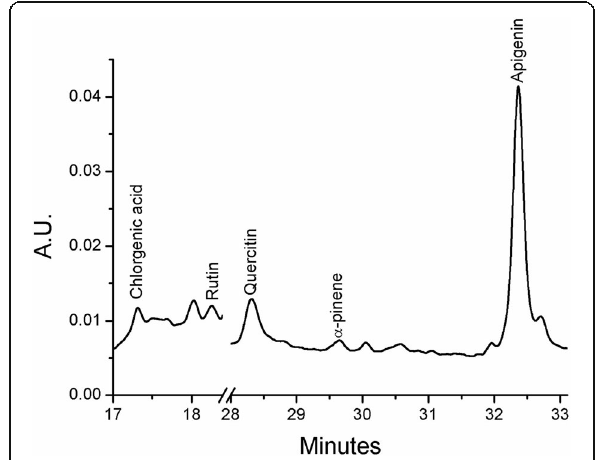
Fig. 3 HPLC chromatogram of the juniper extract, presenting the selected compounds